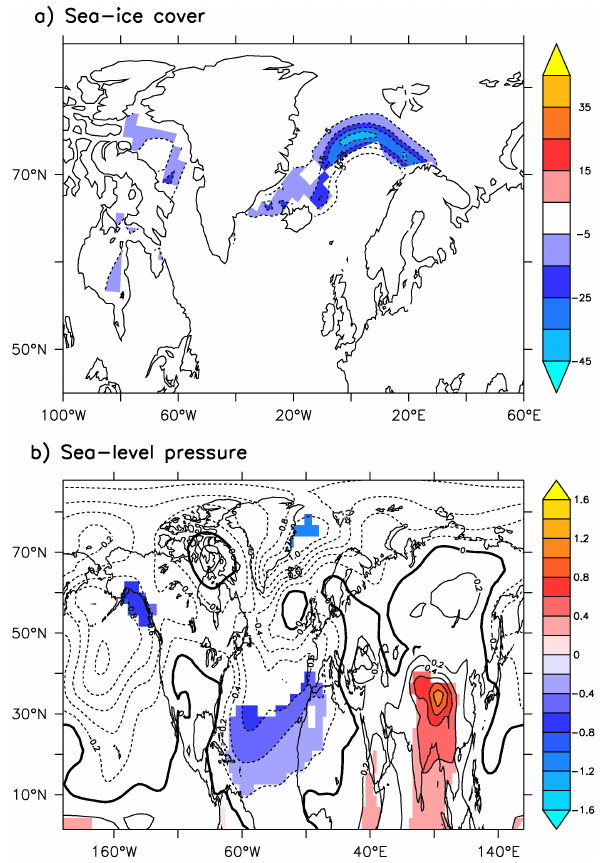
Fig. 8. Similar to Fig. 3 but for (a) sea-ice cover (in %/Wm − 2 ) and Figure 8: Similar to Figure 3 but for a sea-ice cover (in W.m -2 /W.m -2 ) and b sea-level 2 (b) sea-level pressure (in hPa/Wm − 2 ). The significant regions at pressure (in hPa/W.m -2 ). The significant regions at the 95% level are shaded in color. 3 the 95% level are shaded in